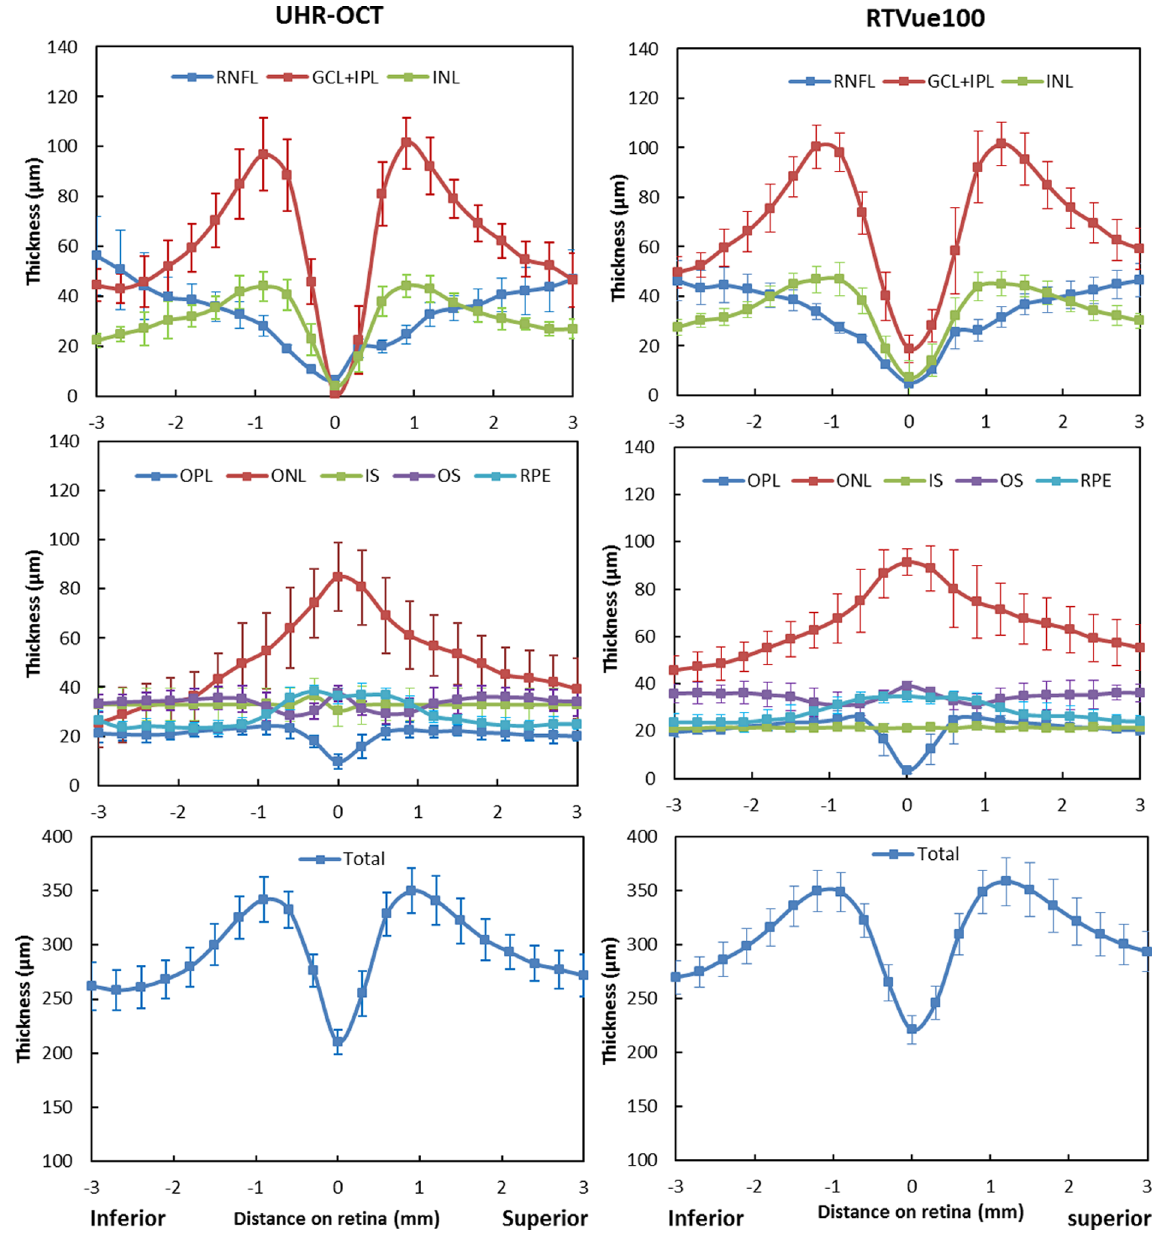
Figure 4. Thickness profiles of eight intra-retinal layers determined from the UHR-OCT and RTVue100 images in the vertical meridian. Thickness profiles of eight intra-retinal layers along the vertical meridian were averaged for 20 normal healthy eyes. Error bars represent standard deviation.